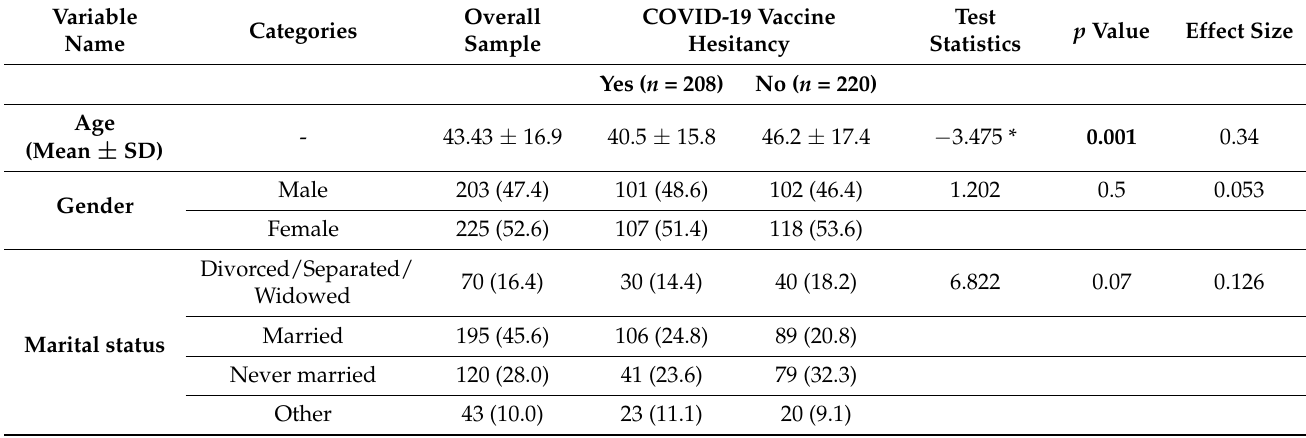
Table 2. Demographic characteristics of the sample population ( n =